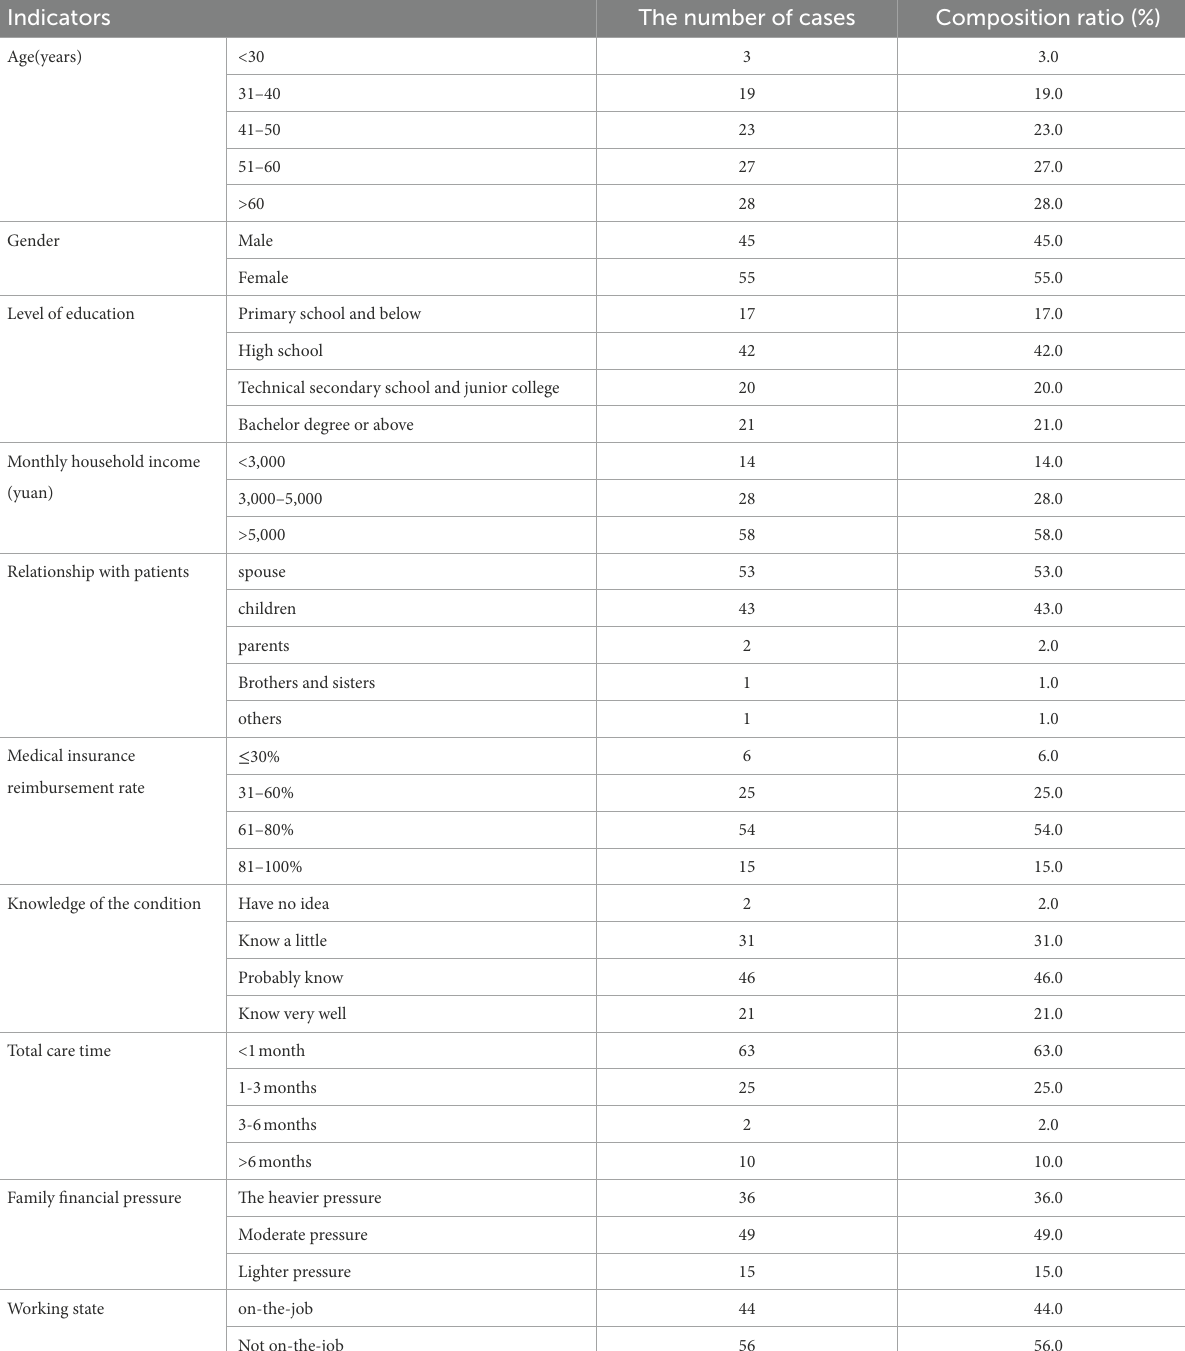
TABLE 1 General Information Questionnaire of caregivers of pancreatic cancer ( n =